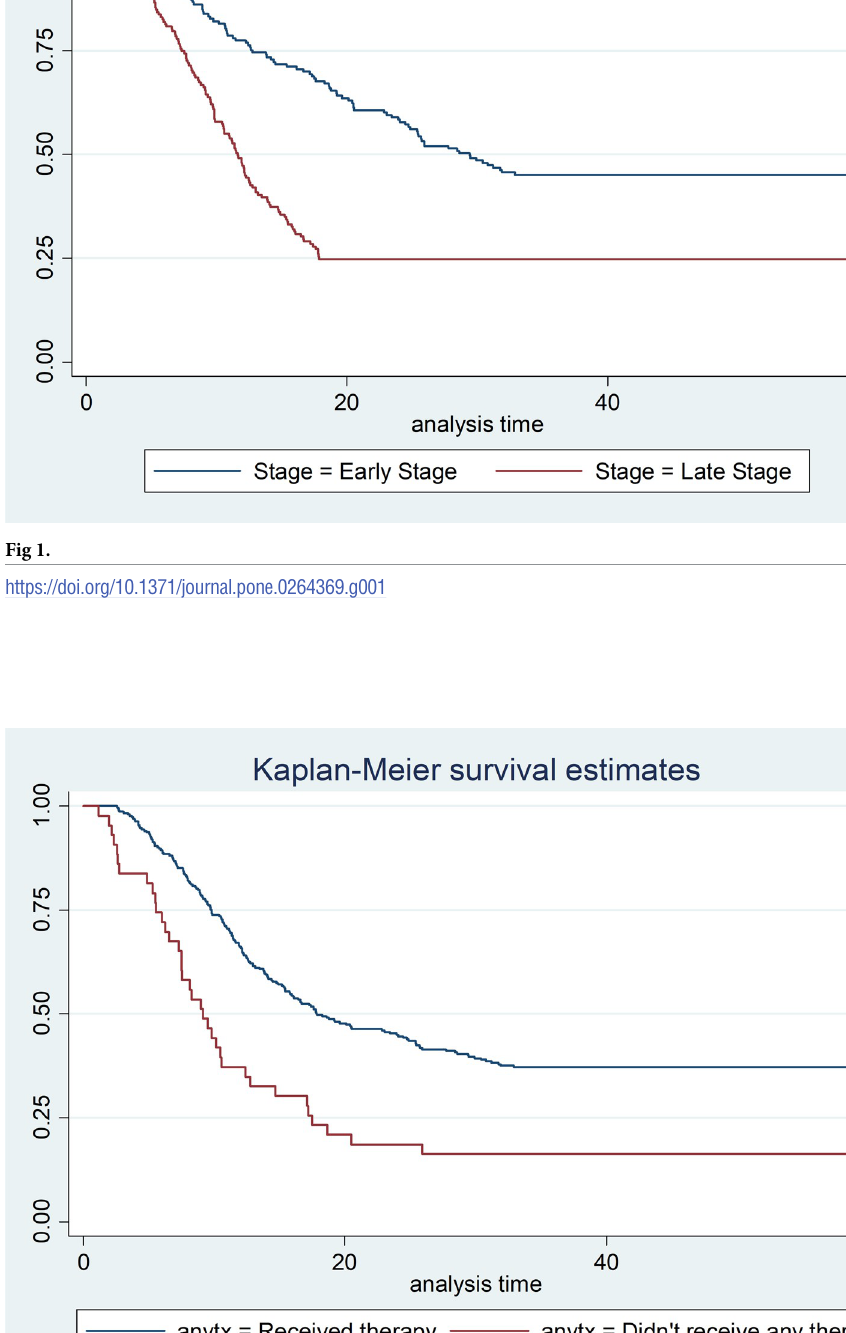
PLOS ONE | https://doi.org/10.1371/journal.pone.0264369 February 24,